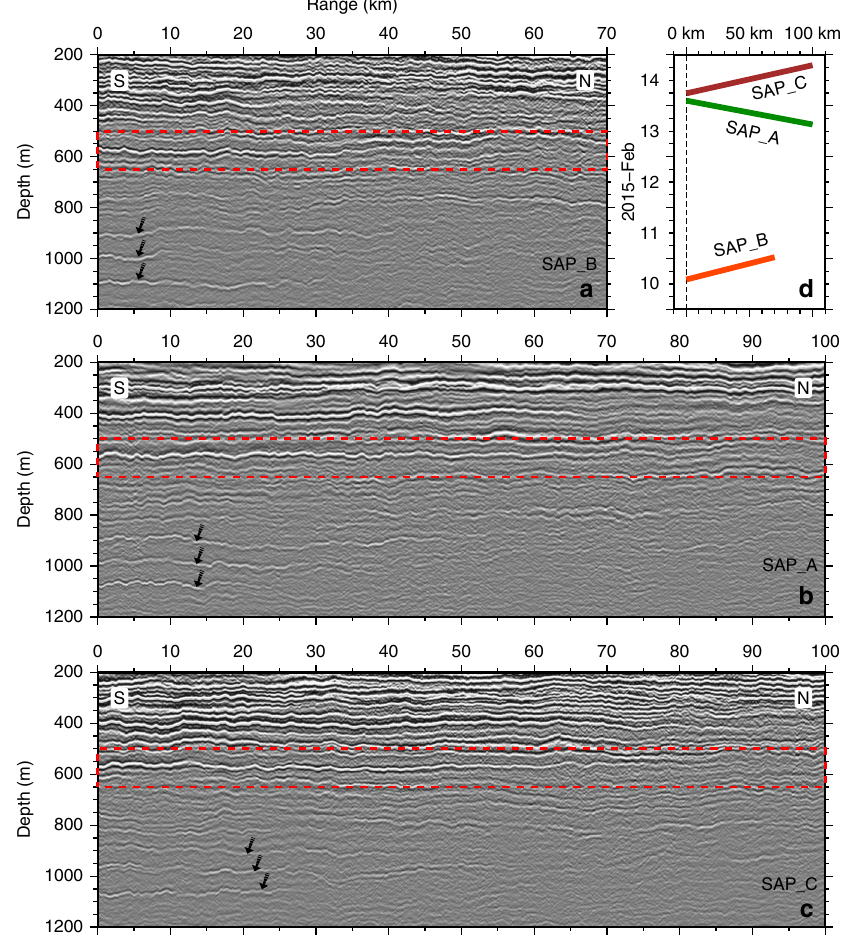
Fig. 2 Seismic images from 200 to 1200 m depth. Three time-lapse seismic sections a SAP_B, b SAP_A, c SAP_C, and d their acquisition time. SAP_B and SAP_A are co-located but separated in time by ~3 days whereas SAP_A and SAP_C were collected consecutively but are spatially separated by 15 km. The boxes (red dashed lines) highlight the target re fl ections shown in Fig. 3. The consistent spatial relationship between the target re fl ections and the co- existing three-re fl ection group (black arrows) give con fi dence that we are tracing the same re fl ector on the time-lapse and spatially shifted sections